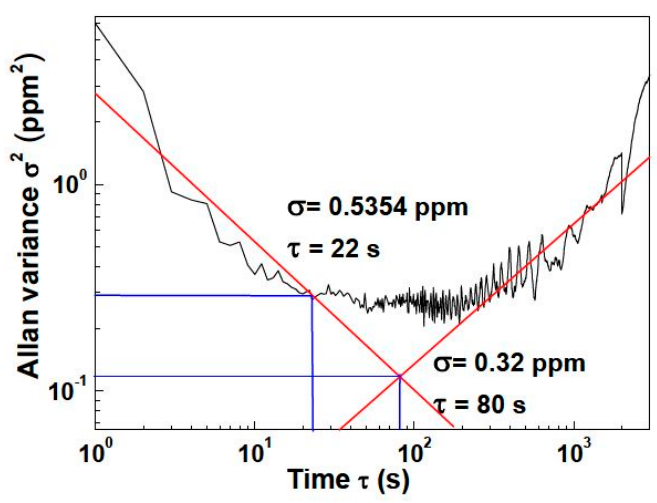
Figure 9. The Allan variance plot of this sensor at a pure N 2 atmosphere.